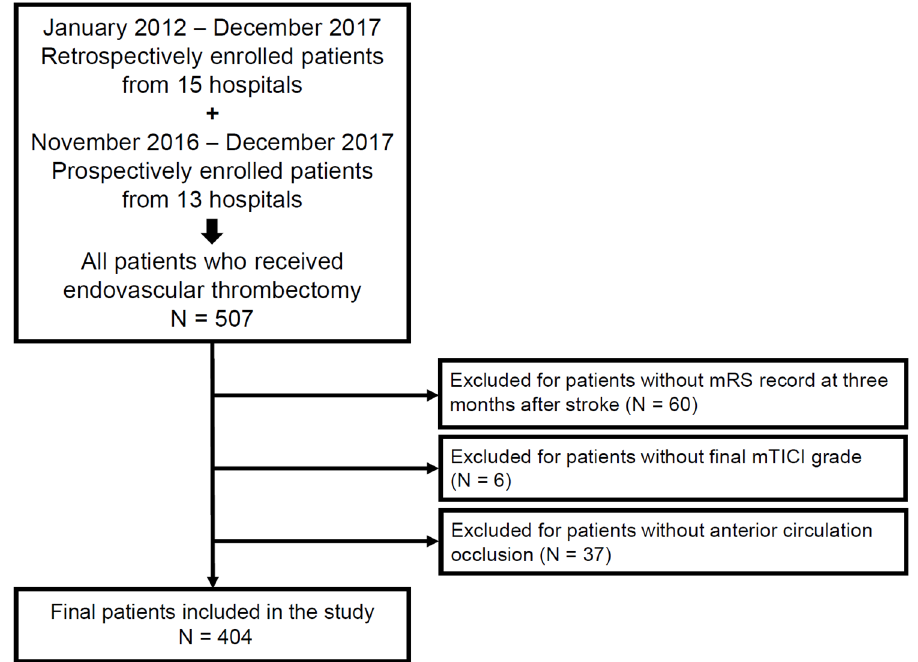
Figure 1. Patient selection strategy used in the study. mRS, modified Rankin Scale; mTICI, modified thrombolysis in cerebral infarction.